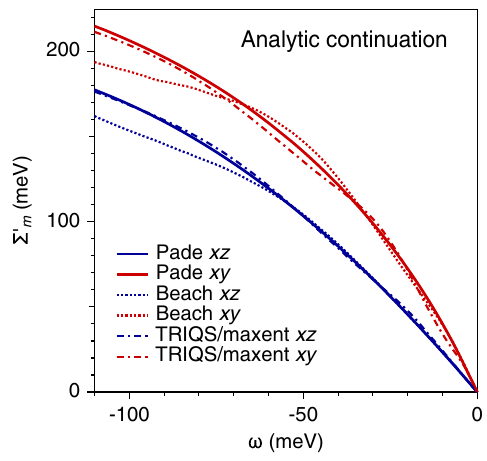
FIG. 12. The real part of DFT þ DMFT self-energy in the considered energy range obtained with three different analytic continuation methods: Pad´e approximants (using TRIQS [99]), stochastic continuation (after Beach [100]), and maximum entropy (using TRIQS/maxent [101]). The difference between the analytic continuation methods is smaller than the exper- added to cf imental